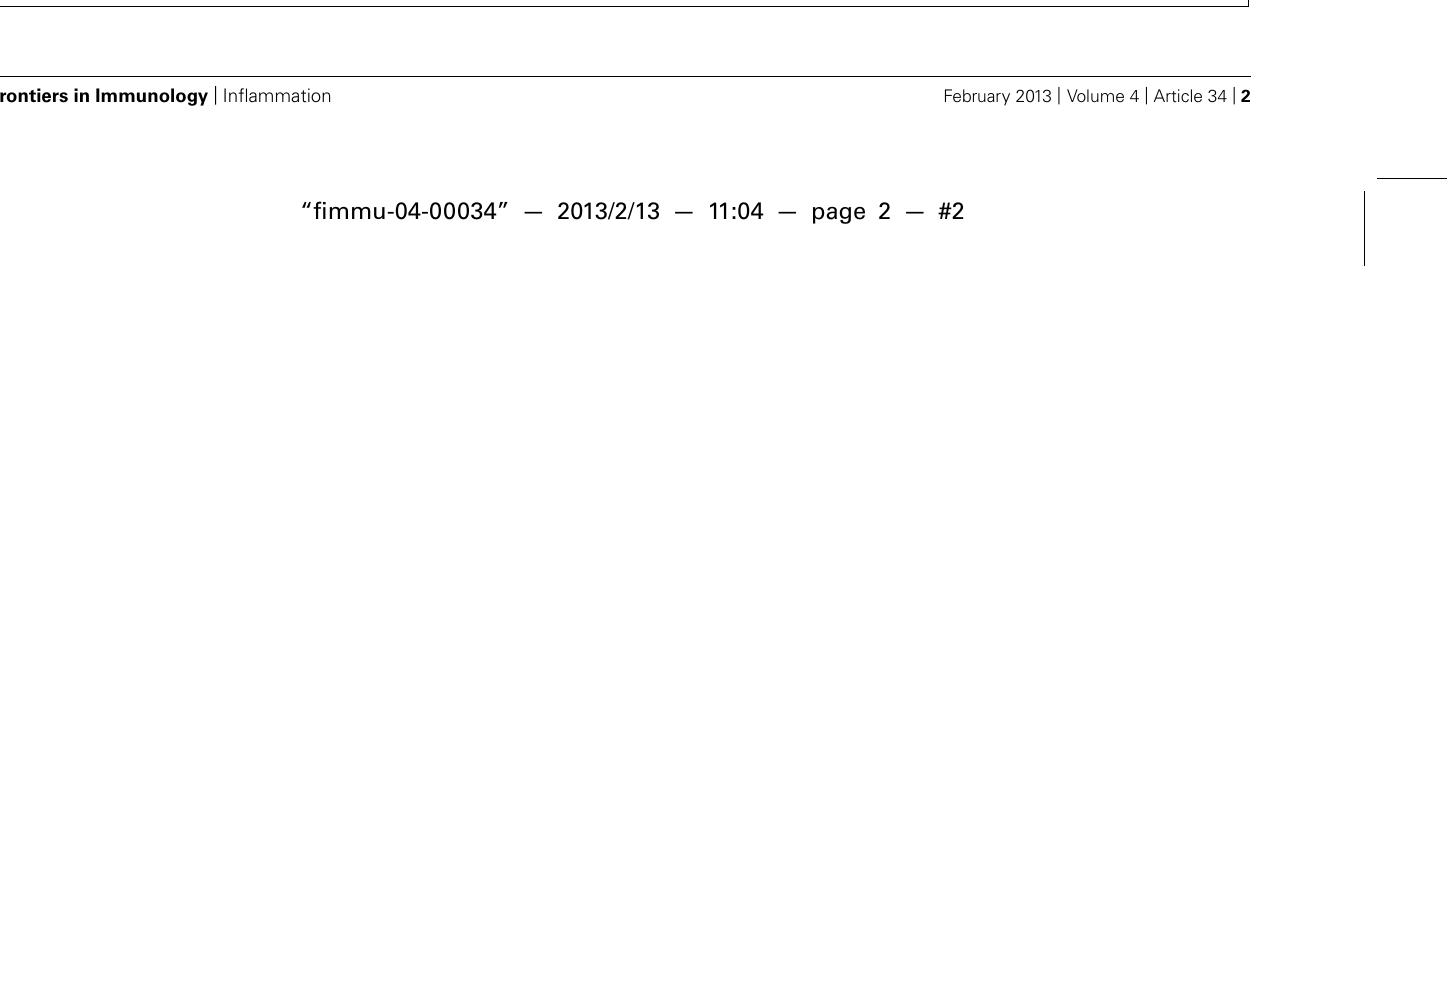
Frontiers in Immunology |